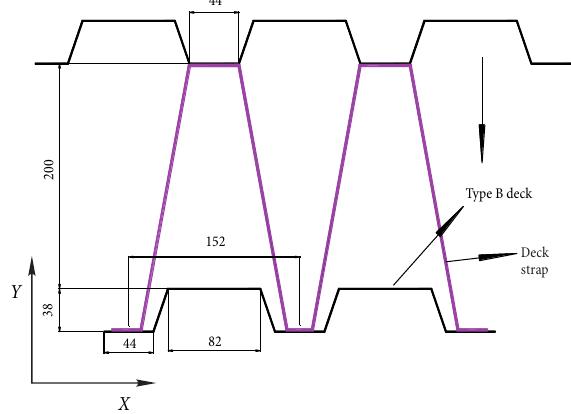
Fig. 1. Schematic of the proposed deck strap (in